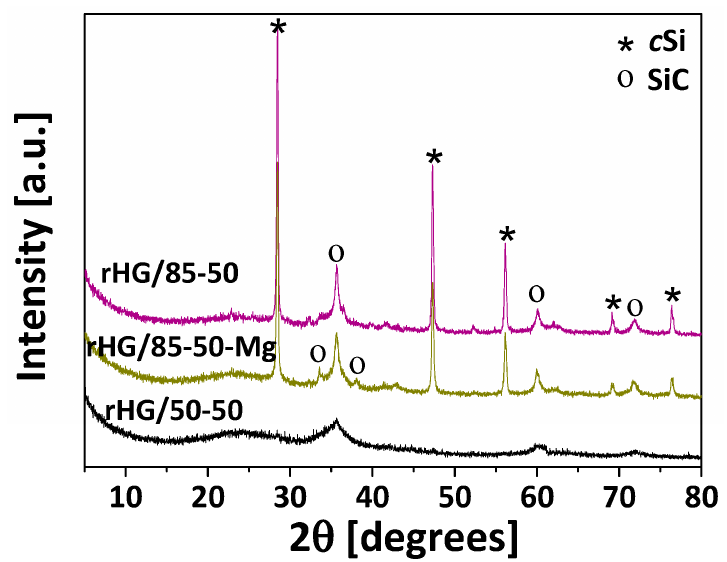
Figure 3. Crystalline species developed on reduced hybrid materials using different Mg/Si ratios.